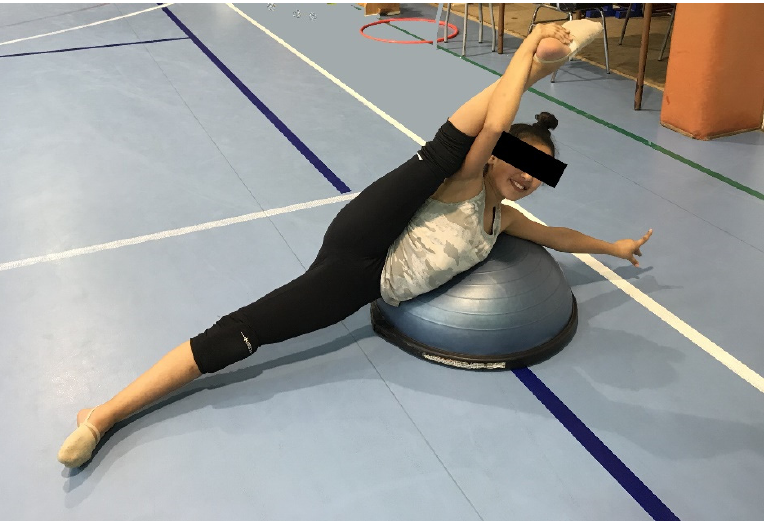
Figure 2. Example of one RG functional CS exercise .